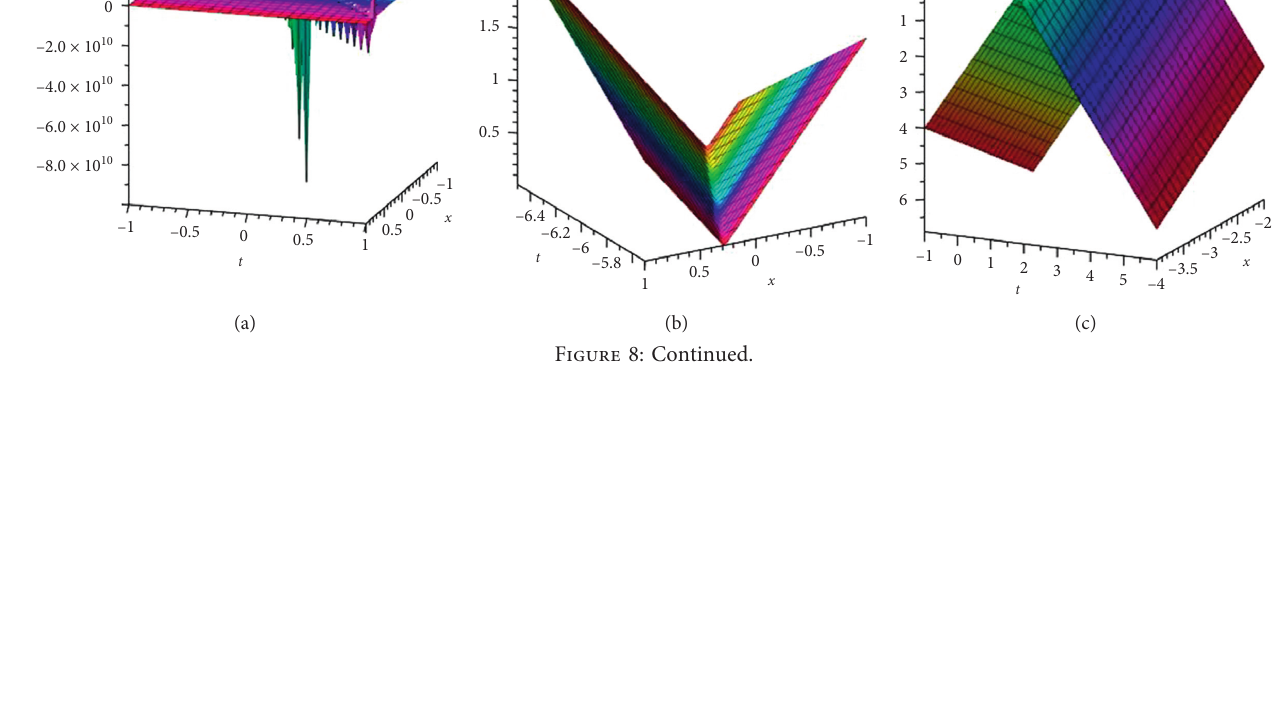
Figure 7: 3D graphics of Families 19, 20, and 21 under the values of α � 1 . 5, k � y � 1, ω � 0 . 5, μ � 0 . 25, and A � 2 . 5 for (a) Φ with β � 1 σ � 0, l � 1, and m � 0 . 5, and (c) Φ and σ � 0 . 5, (b) Φ 32